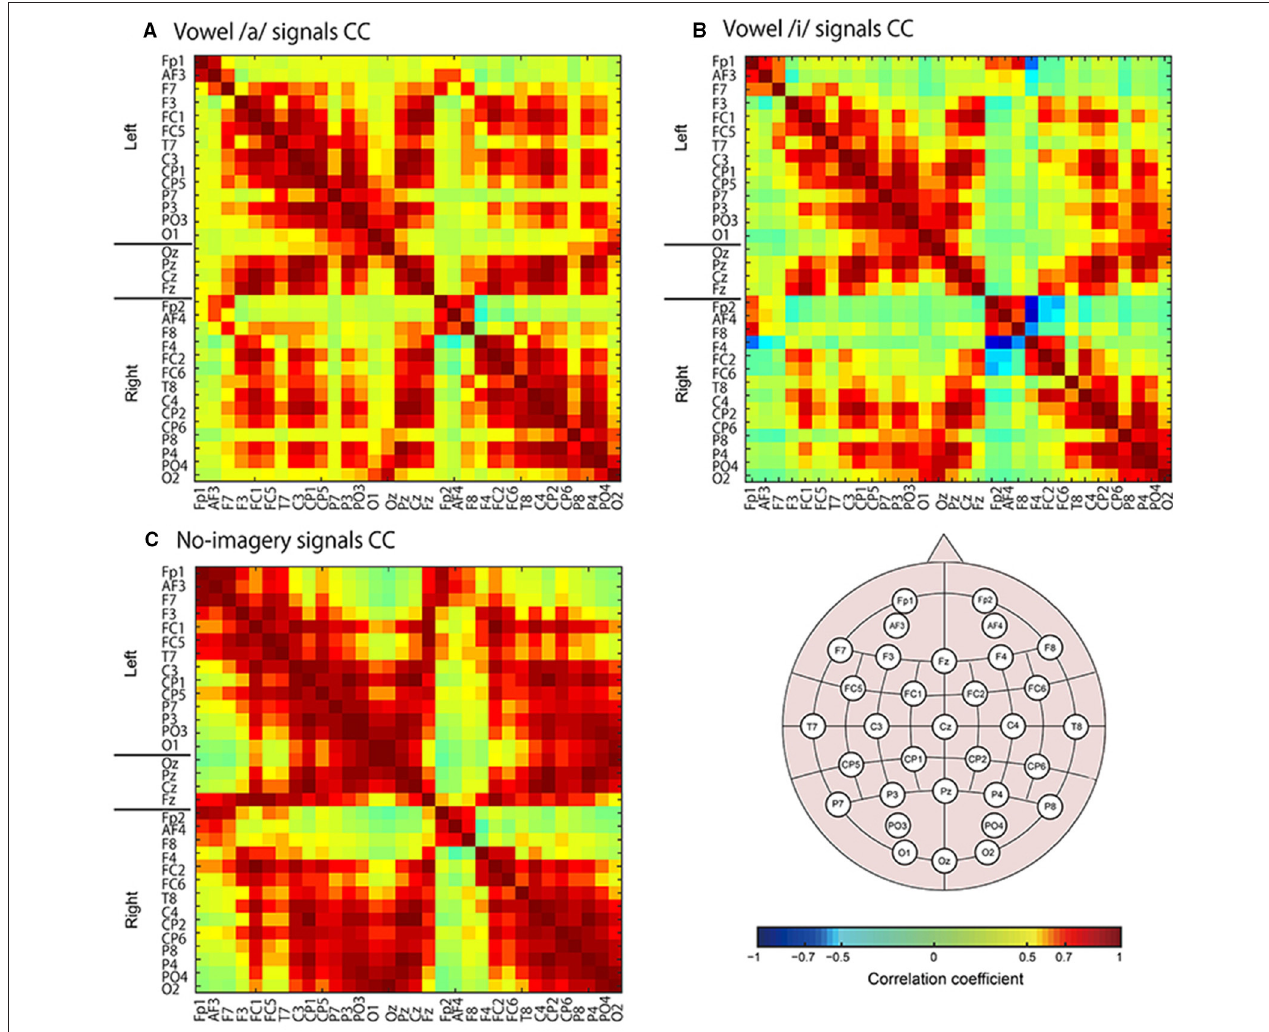
FIGURE 8 | Color maps of correlation coefficient (CC) values for EEG sensor signals. Sensors names are listed along with the horizontal and vertical axes. CC values were calculated for all tasks signals: vowel /a/ (A) , vowel /i/ (B) , and no-imagery (C) .